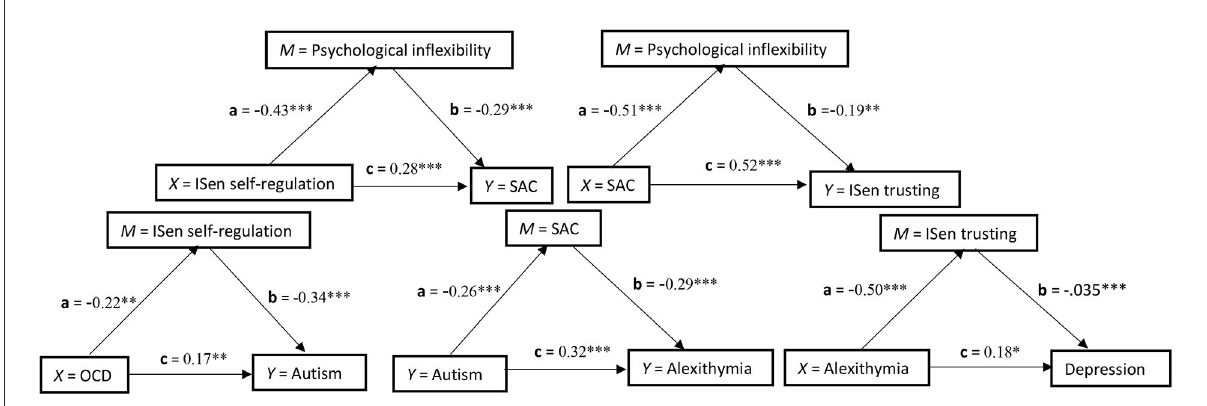
FIGURE1 Five simple independent mediation models stacked in conceptual hierarchy and showing the standardized coefficients of each path. * p < 0.05; ** p < 0.01; *** p < 0.001.